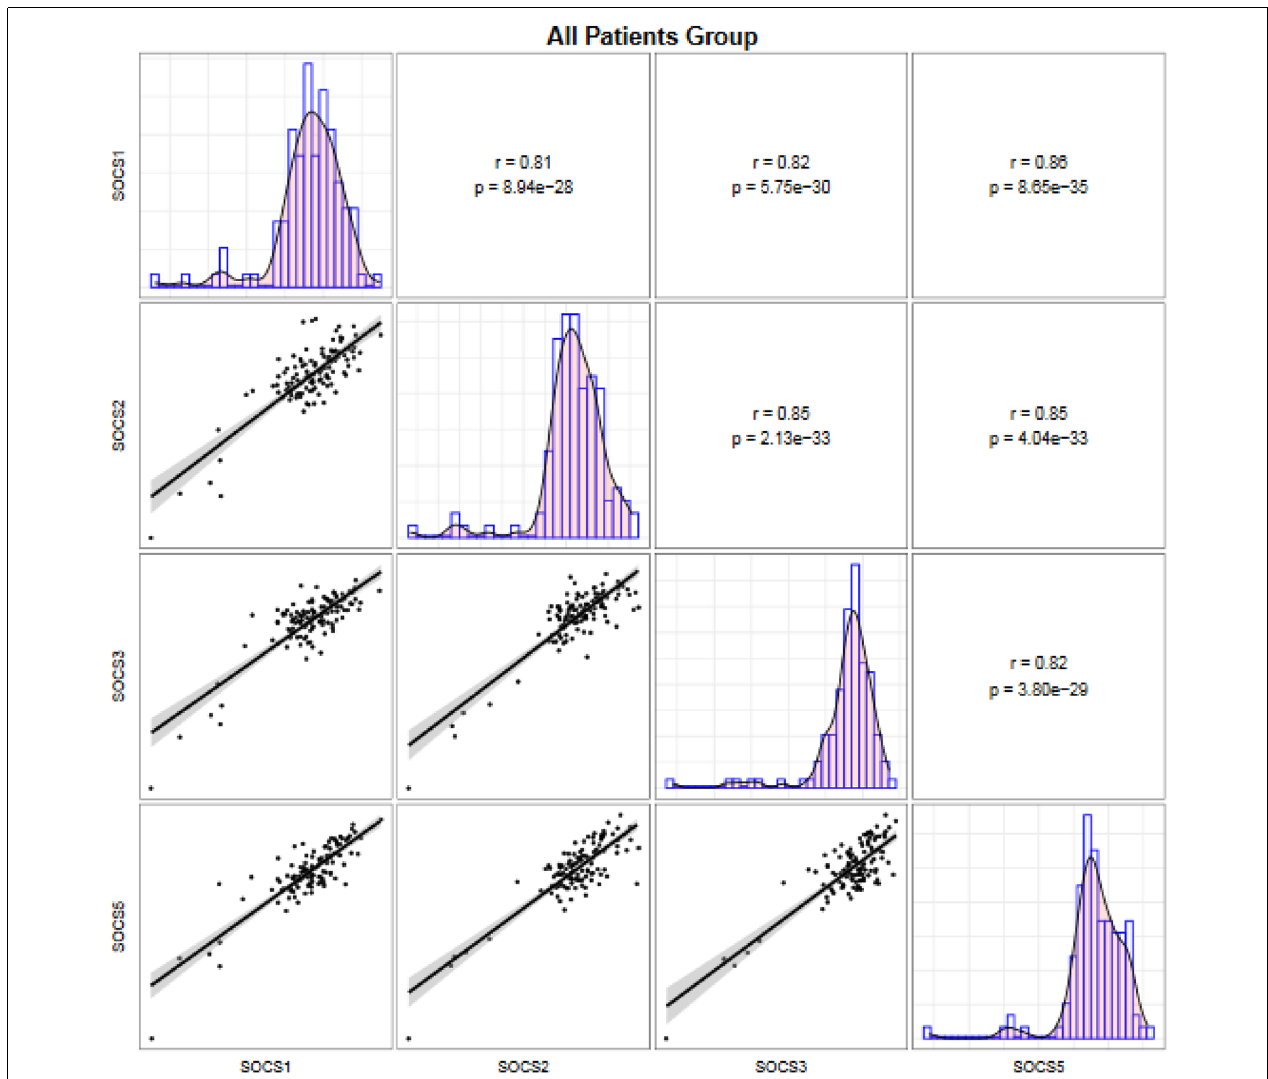
FIGURE 2 | Correlation between transcript levels of the SOCS genes among patients. Distributions of expression data of the SOCS gene are presented on the diagonal. The bivariate scatter plots are shown on the bottom of the diagonal. The upper part of the diagonal shows correlation coefficients (r) and P values.